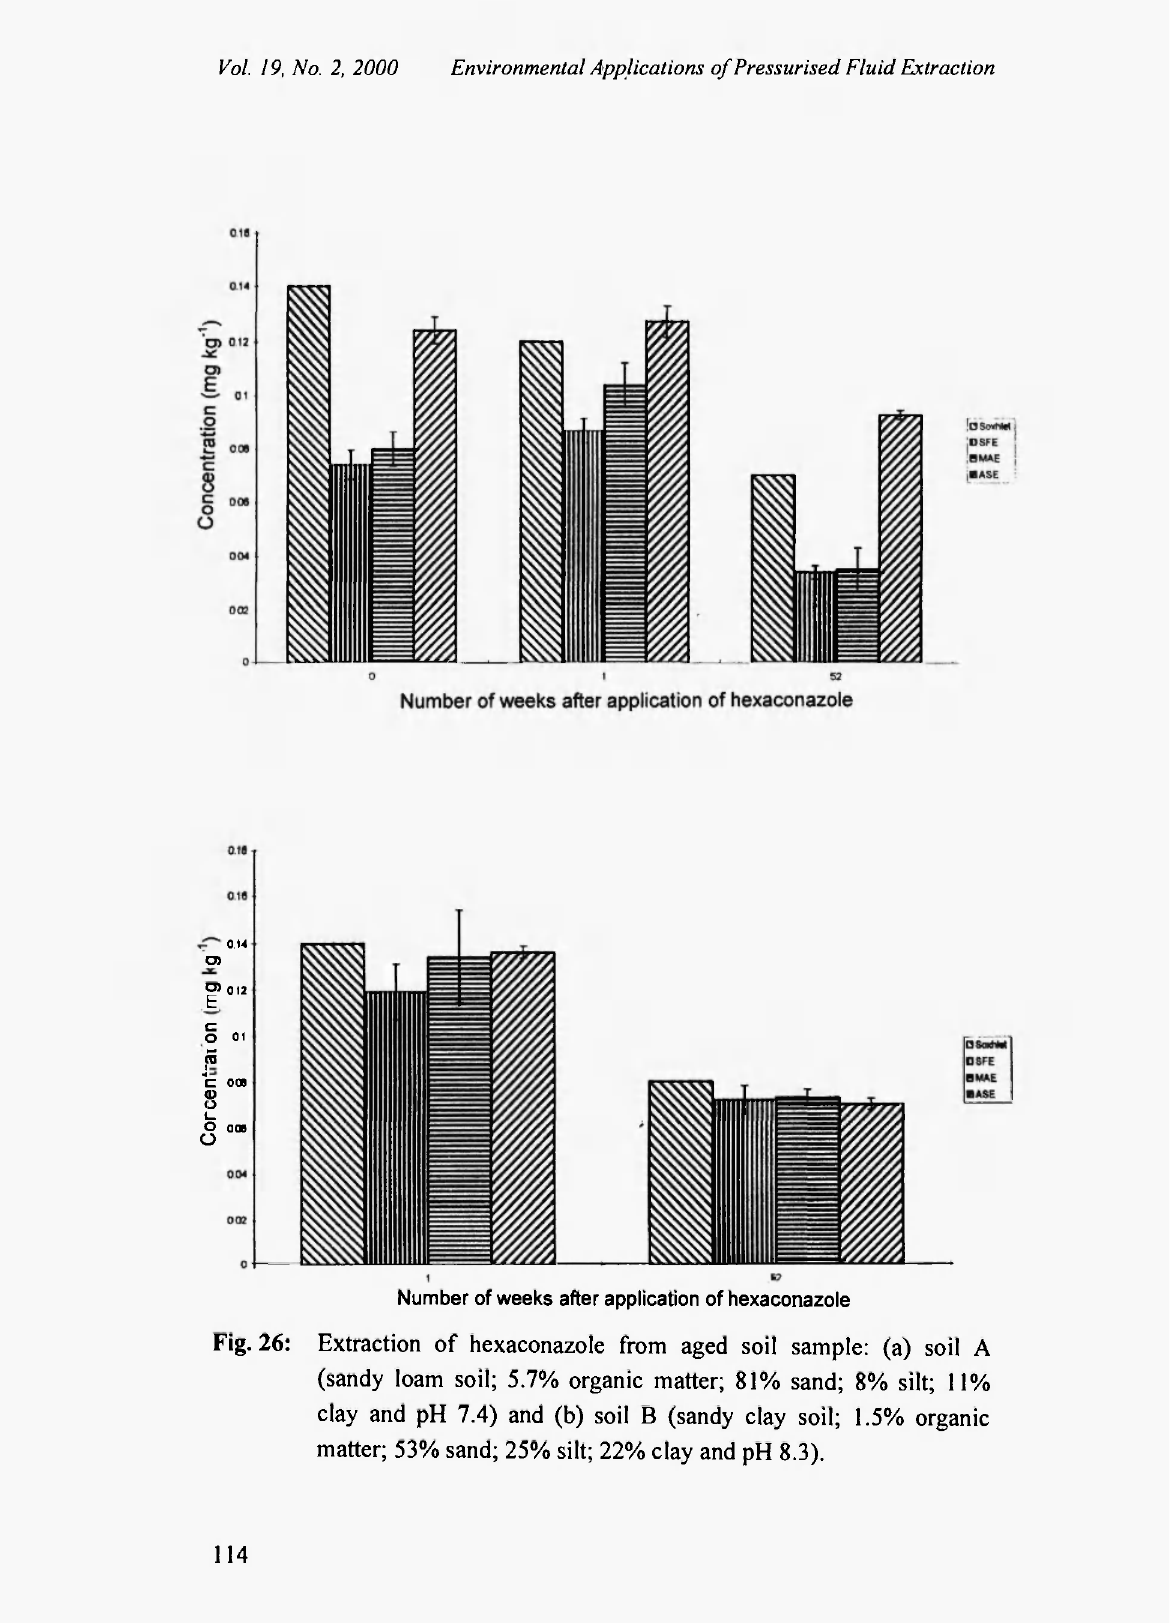
Extraction of hexaconazole from aged soil sample: (a) soil A (sandy loam soil; 5.7% organic matter; 81% sand; 8% silt; 11% clay and pH 7.4) and (b) soil Β (sandy clay soil; 1.5% organic matter; 53% sand; 25% silt; 22% clay and pH